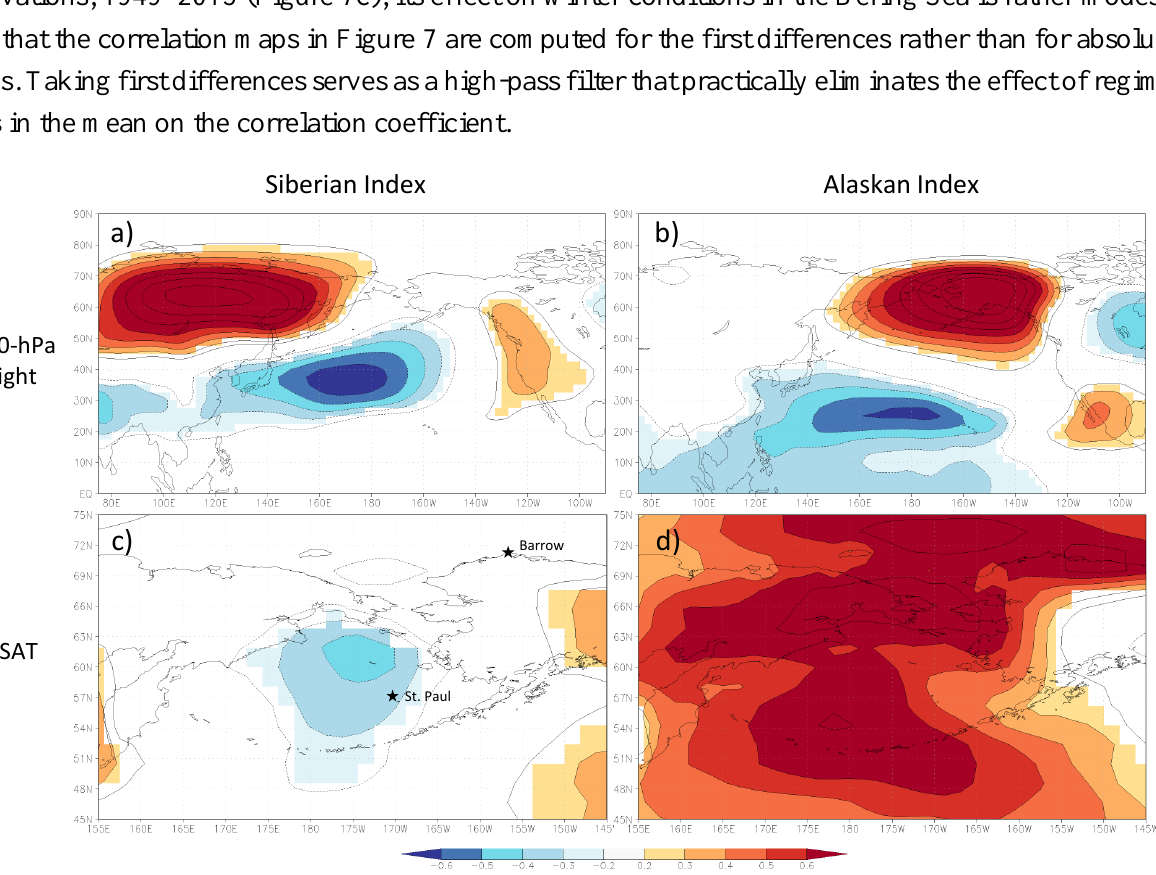
Figure 7. Correlation maps for the Siberian ( left column ) and Alaskan ( right column ) indices in the mean winter (DJFM) 700-hPa ( a , b ) height and ( c , d ) SAT fields. The correlation coefficients were calculated using the entire dataset, 1949–2015. The first differences filter ( ∆𝑥 ) was applied. Areas where the correlation coefficients are statistically = 𝑥 − 𝑥 𝑖 𝑖 𝑖−1 significant at the 90% confidence level are